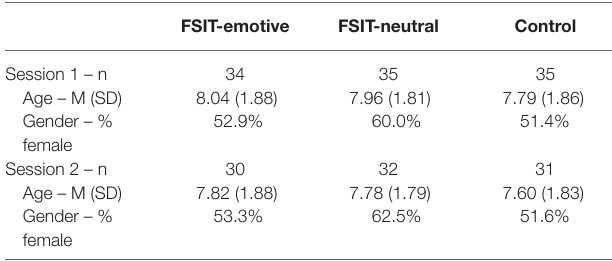
TABLE 1 | Sample characteristics for each condition at each